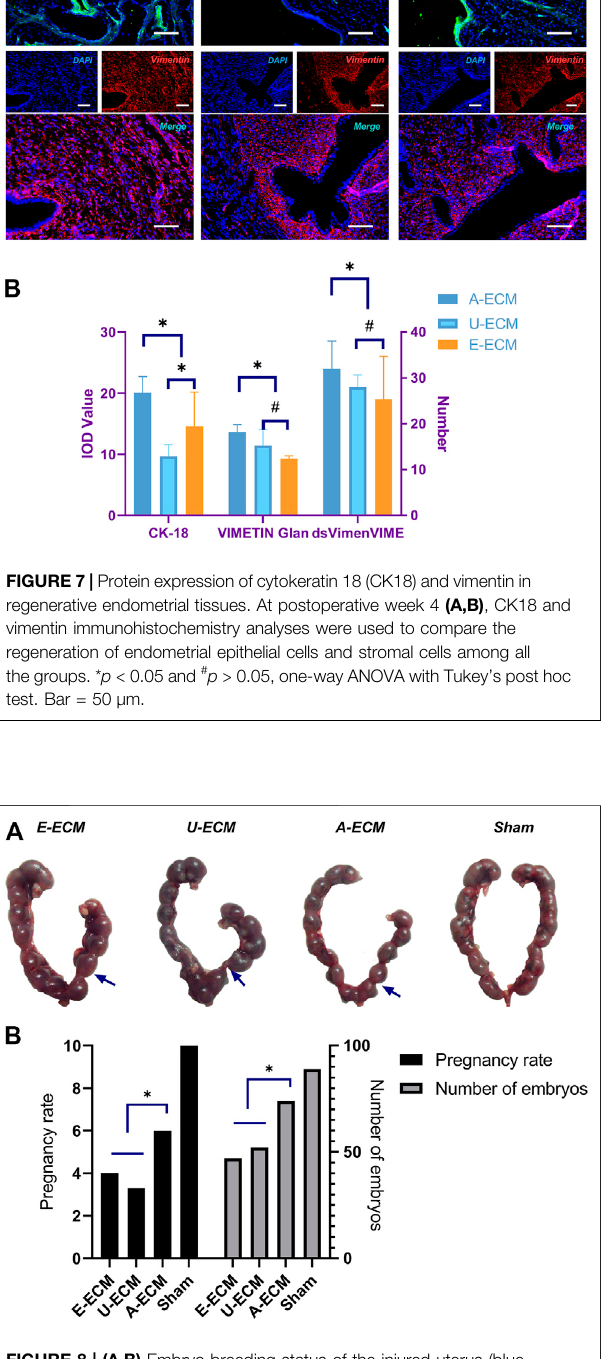
FIGURE 8 | (A,B) Embryo breeding status of the injured uterus (blue arrows) in all groups.* p < 0.05, one-way ANOVA with Tukey ’ s post hoc test.Arrows shown the damaged area of the uterine horn in each